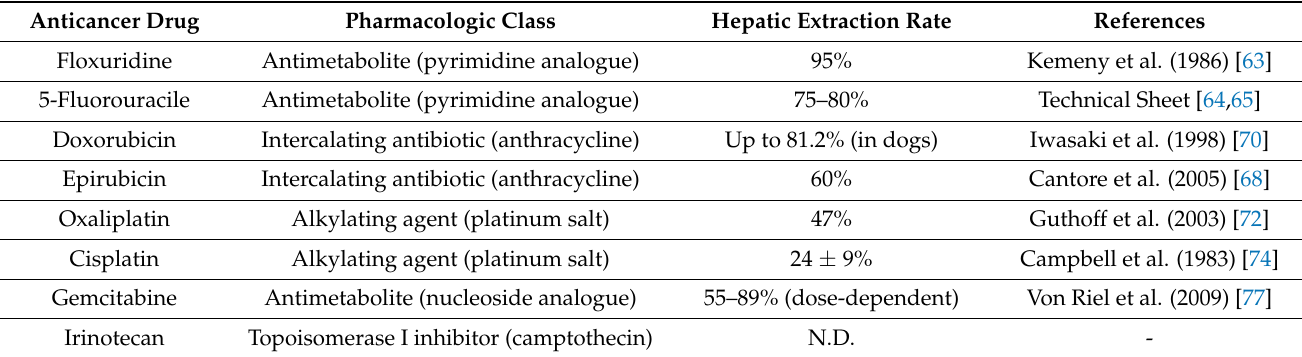
Table 2. Anticancer drug clinically used and/or tested for HAI